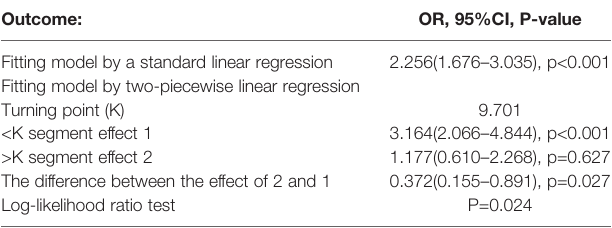
TABLE 4 | Threshold effect analysis of TyG index and CIN.